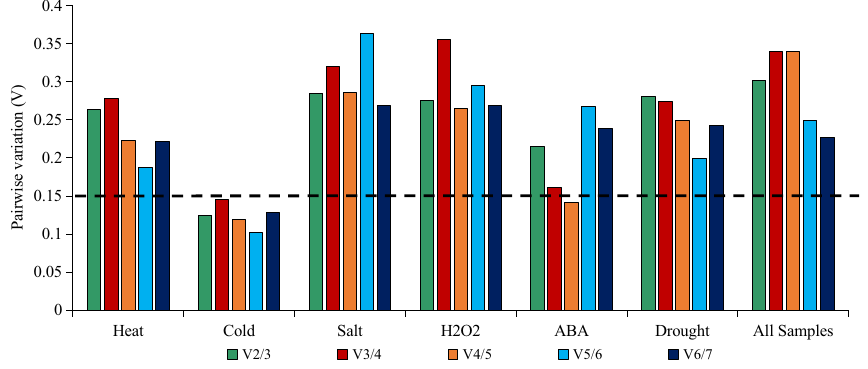
Figure 6. geNorm analysis of the V values for the seven reference genes under various conditions.